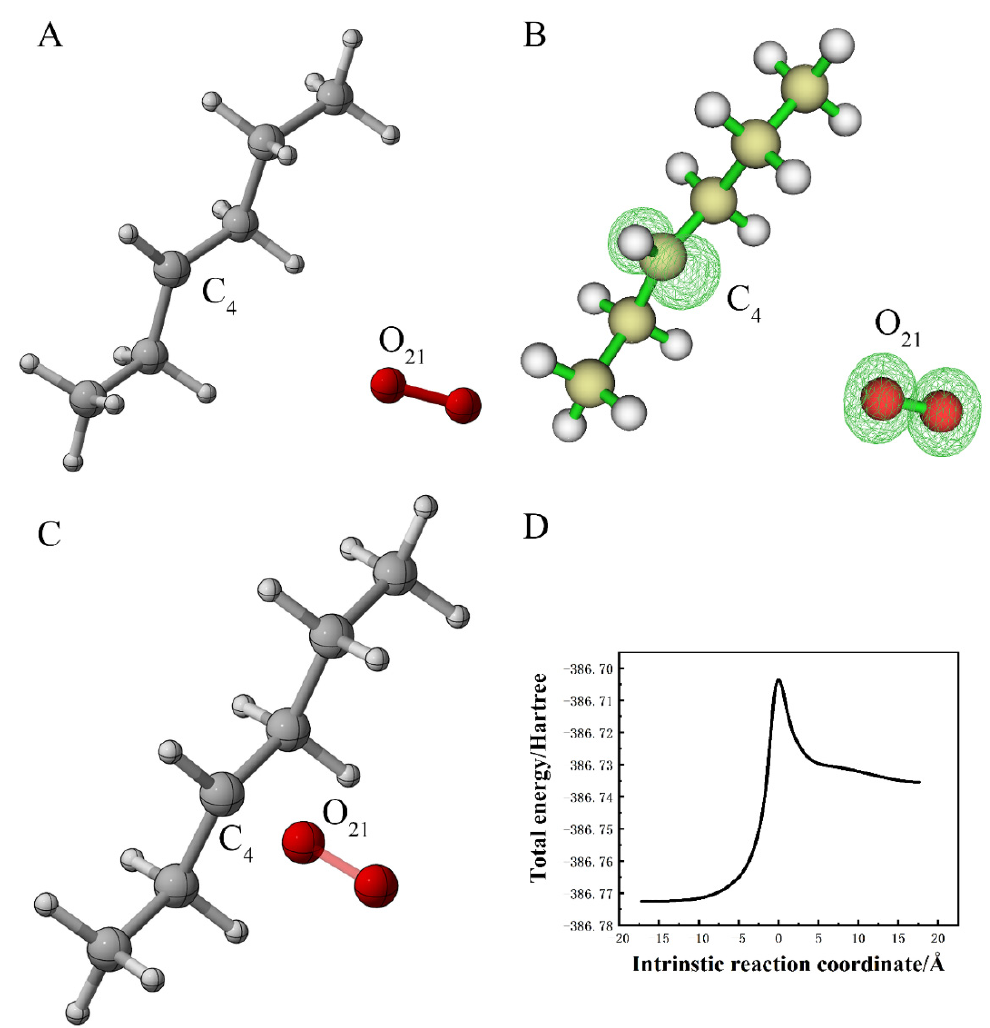
Figure 3. ( A ) Reactant of alkane radical with oxygen in the quadruple state; ( B ) spin density of the structure as shown in ( A ) (the value of the iso-surface is 0.01); ( C ) transition state; ( D ) IRC analysis potential energy curve.